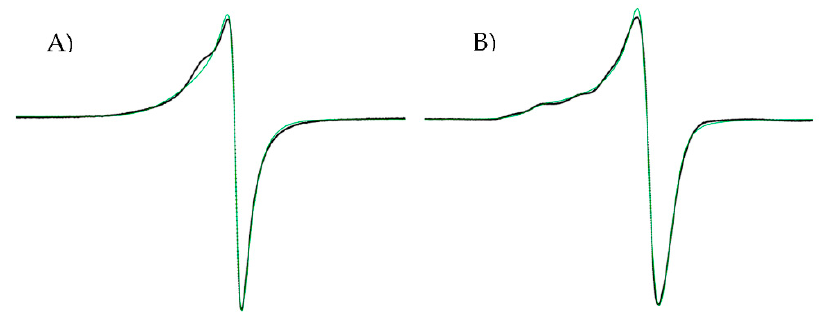
Figure 3. EPR spectra. ( A ) Complexed D7CuL1 and ( B ) complexed D6CuL2.